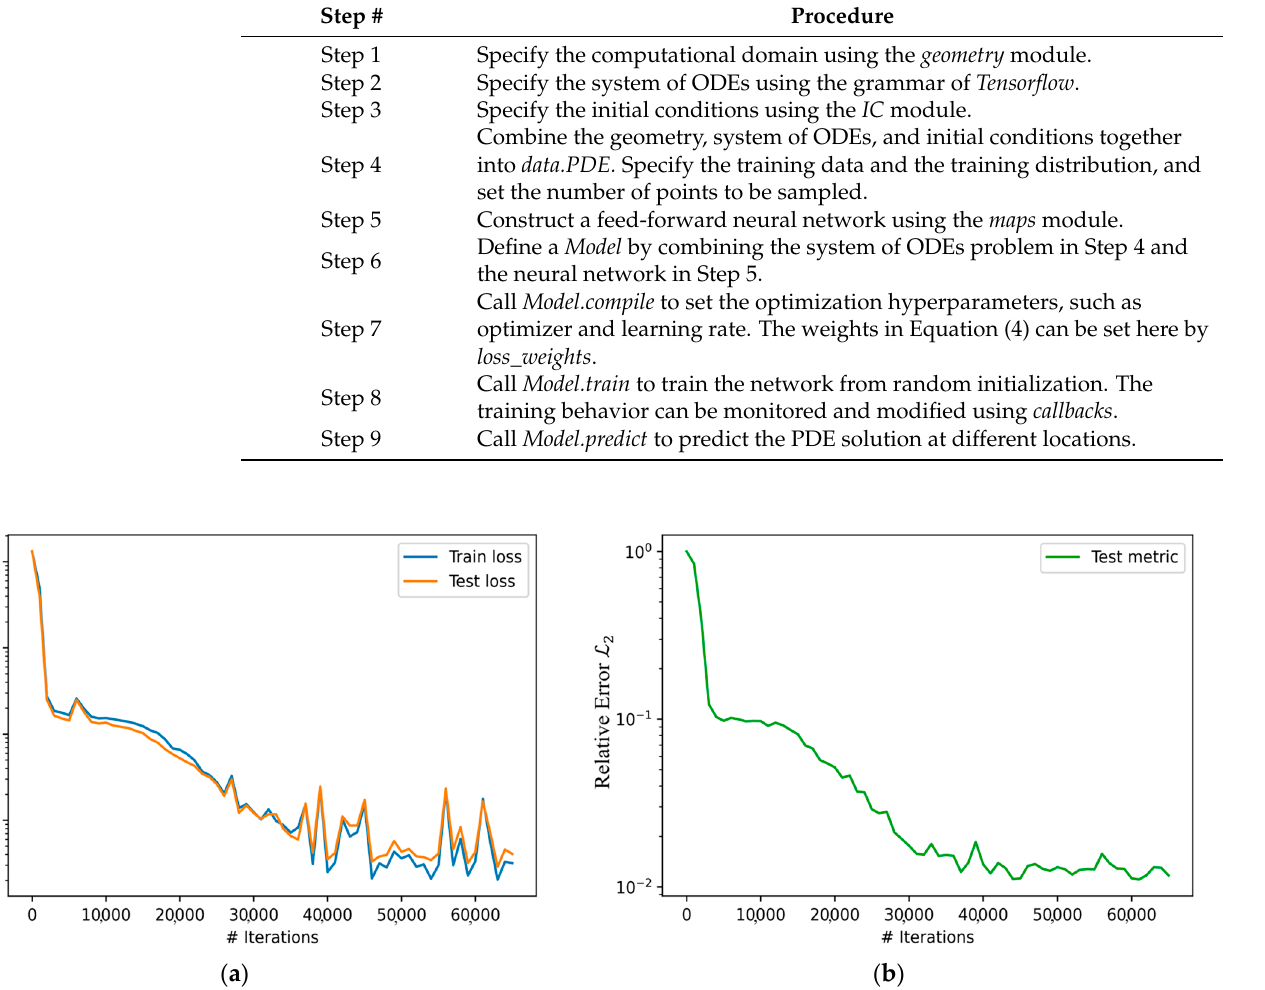
Table 3. Workflow for solving PKEs using PINNs in DeepXDE framework. Step #